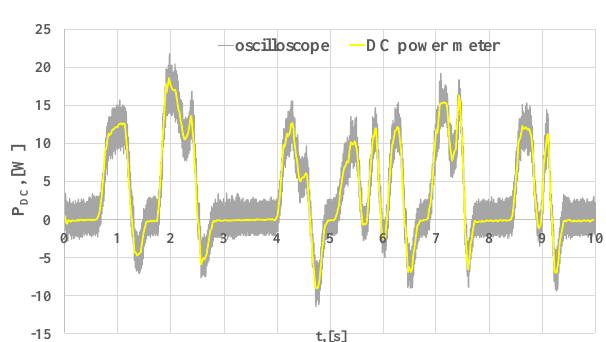
Fig. 10. The first case: dynamic power flow measurements from the novel DC power meter and the Rigol DS1104Z oscilloscope.